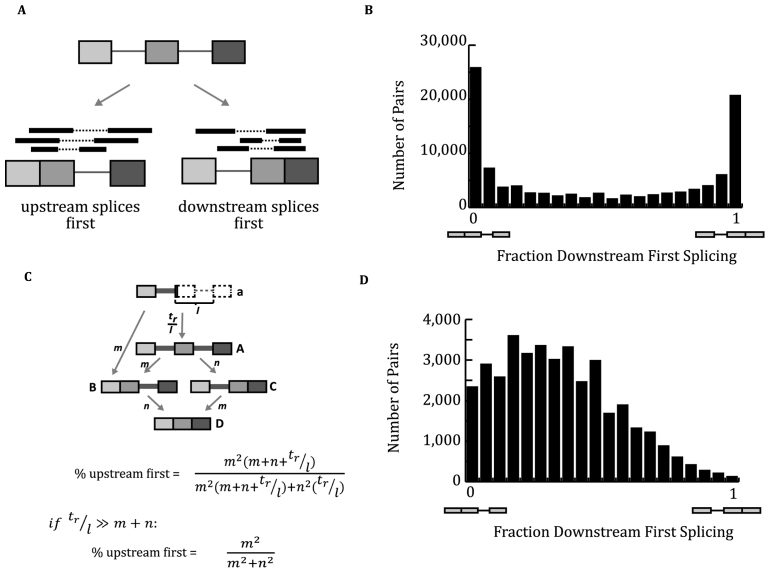
Genome-wide analysis of order of splicing showed excess of always-first events. (A) Pipeline to determine the order of intron removal. ENCODE non-PolyA RNA reads were analyzed to count reads that mapped to partially spliced species. Partially spliced species were compared to generate the pairwise fraction downstream intron goes first. (B) Determined order of intron removal in genome-wide scale. All pairwise events were used to compute the frequency of downstream intron splicing first. Events were sorted and binned (x-axis). Pairs that have read counts >10 were included and used for further analysis. (C) Kinetic model of splicing using steady-state assumptions. (D) Simulation of intron removal using purely kinetic model. Using published rates of Pol II elongation and in vivo splicing rates, distribution of splicing order was simulated. Average splicing rate of 0.169 introns/minute, standard deviation of 0.048 and transcription rate of 3.87 kb/min were used (24). Contrary to the observed data, the simulation results did not show excess of always-first events.